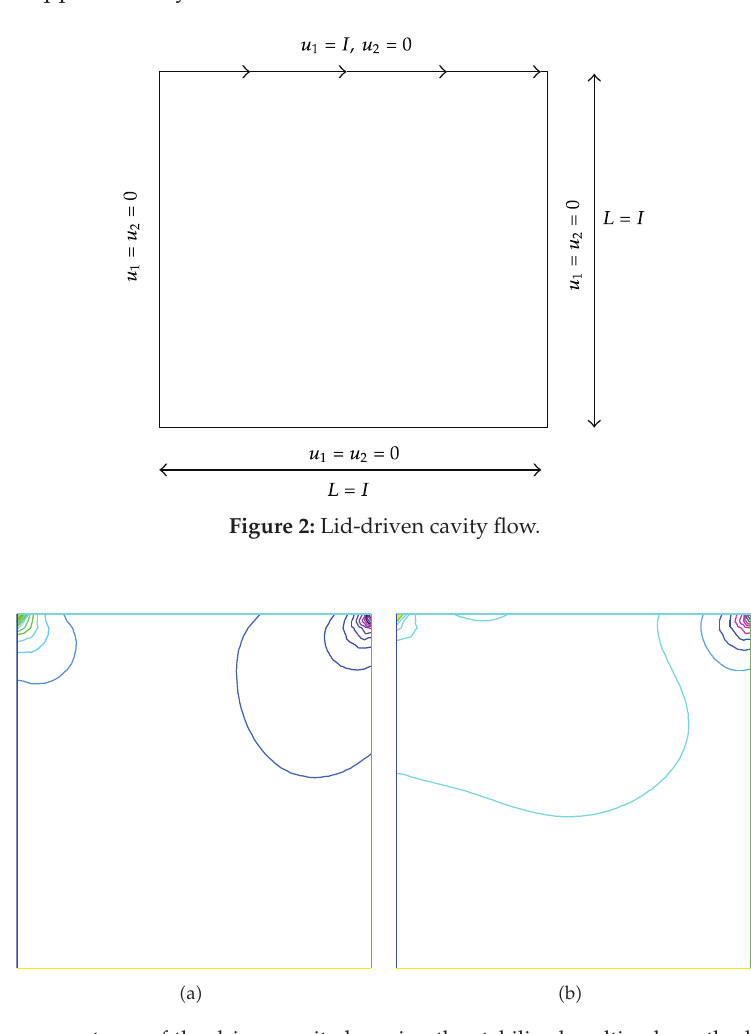
Figure 3: Pressure contours of the driven cavity by using the stabilized multiscale method with NCP 1 - P 1 at di ff erent Reynolds numbers. (cid:4) a (cid:5) Re (cid:10) 1, (cid:4) b (cid:5) Re (cid:10)